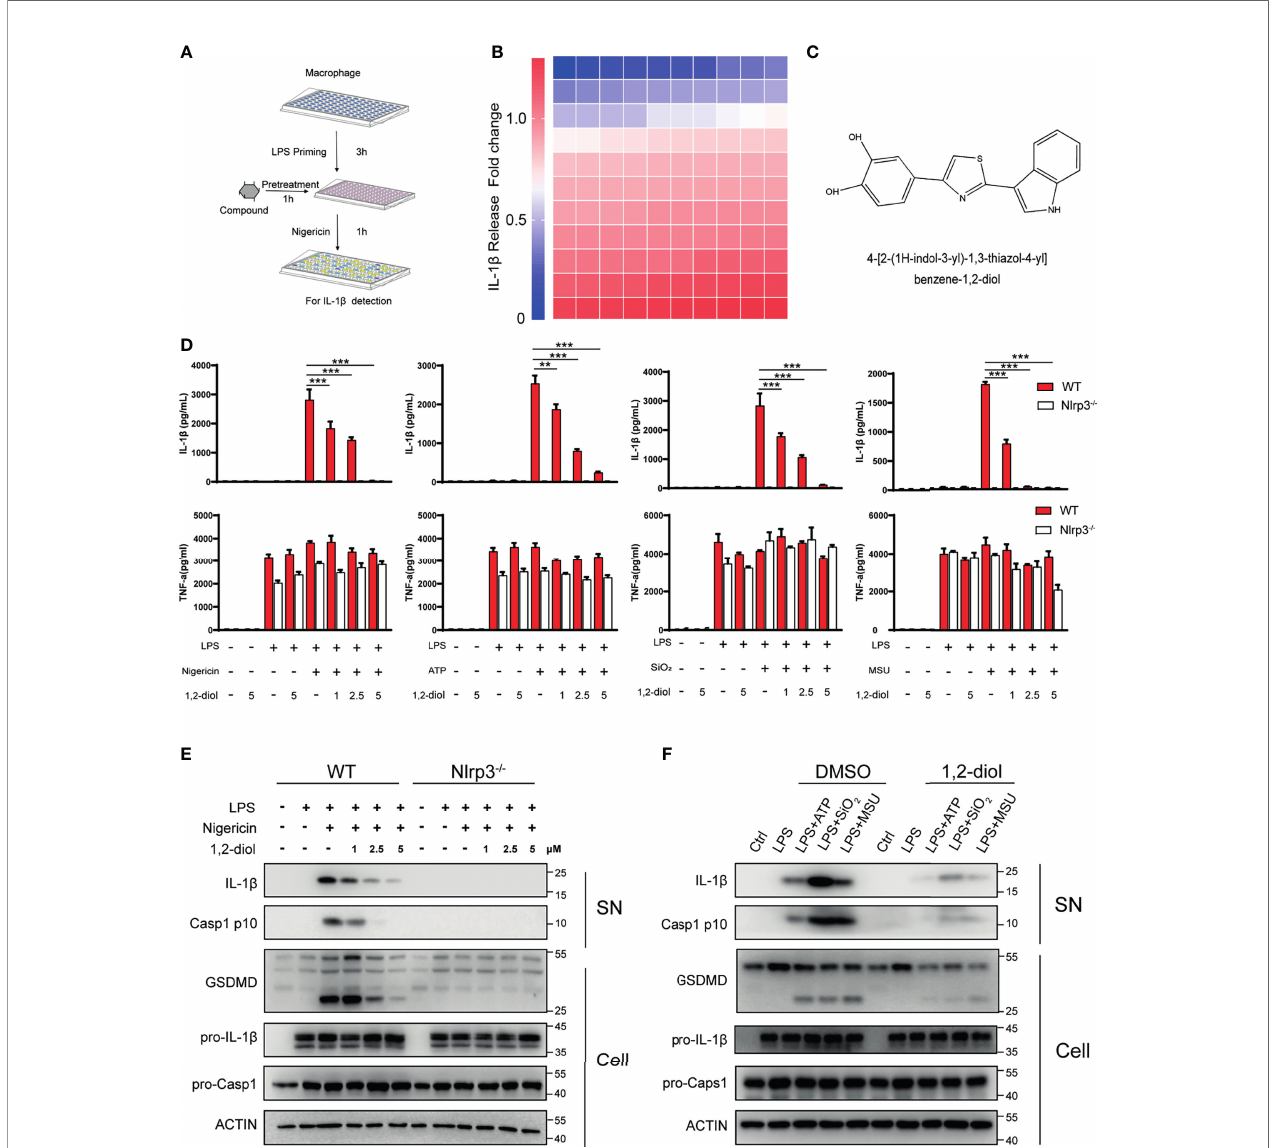
FIGURE 1 | 1,2-Diol blocks NLRP3 activation in mouse peritoneal macrophages. (A) Schematic diagram of the screening steps from the compound library in mouse macrophage stimulated with nigericin and LPS. (B) Heatmap of IL-1 b release changes in LPS-primed primary macrophages treated with 5 m M inhibitors and then stimulated with nigericin with 110 bioactive compounds library. (C) Chemical structure of 4-[2-(1H-indol-3-yl)-1,3-thiazol-4-yl]benzene-1,2-diol. (D) cytokines (IL-1 b and TNF a ) release from WT or Nlrp3 − / − peritoneal macrophages primed by LPS and stimulated with nigericin, ATP, SiO 2 or MSU in the absence or not of 1,2-diol with different doses. (E) Western blots for Caspase-1 and IL-1 b in the supernatant or the cleavage of GSDMD, the expression of pro-Caspase-1 and pro-IL-1 b in the cell lysates of WT or Nlrp3 − / − peritoneal macrophages primed by LPS and stimulated with nigericin in the absence or not of 1,2-diol with different doses. (F) Western blots for Caspase-1 and IL-1 b in the supernatant or the cleavage of GSDMD, the expression of pro-Caspase-1 and pro-IL-1 b in the cell lysates of peritoneal macrophages primed by LPS and stimulated with ATP, SiO2 or MSU in the absence or not of 1,2-diol with 5 m M dose. Graphs show the mean ± SD of technical replicates and are representative of at least three independent experiments. (**p < 0.01; ***p <